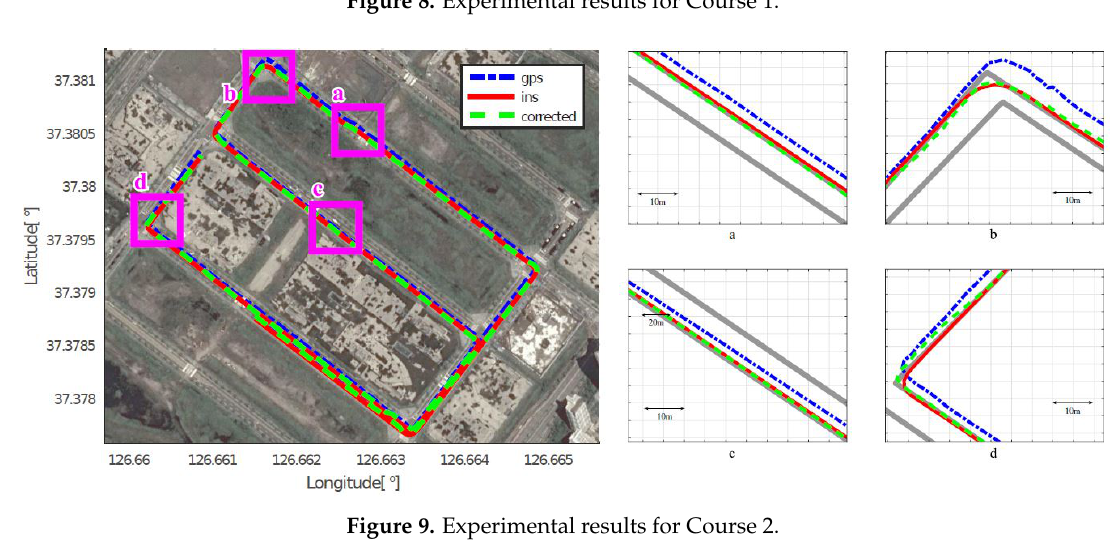
Figure 8. Experimental results for Course 1.